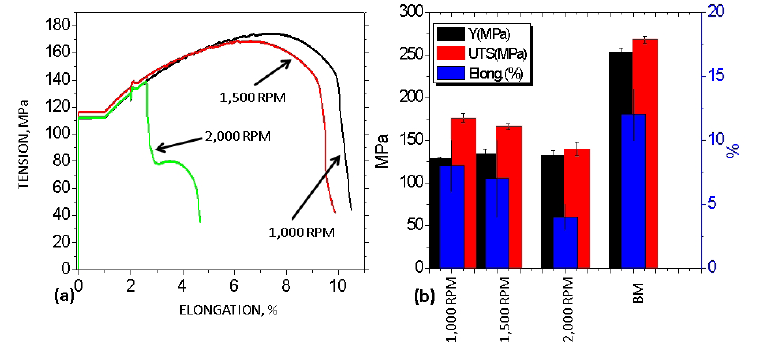
Figure 2. (a) Representative curve of tensile tests and (b) relation of mechanical properties of the extruded samples after FSW processing, where YS represents the yield strength, UTS the ultimate tensile strength, and ELONG the elongation.